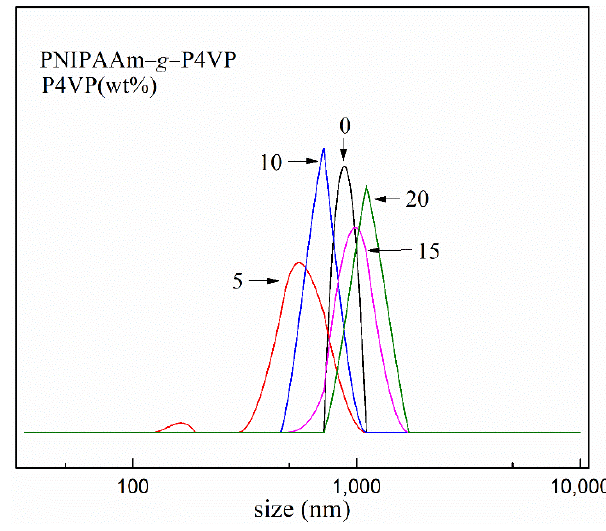
Figure 3. Particle size distribution of PNIPAAm microgel modified by P4VP.